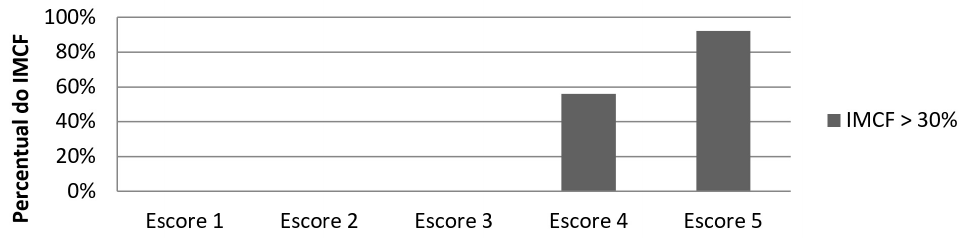
Figura 1. Distribuição (em porcentagem) dos gatos com índice de massa corporal felino maior que 30%. Observa-se que todos apresentavam escore de sobrepeso ou obesidade, ou seja, 4 ou 5. Não houve ocorrência deste IMCF nos animais com escore 1, 2 ou 3. Rio de Janeiro,